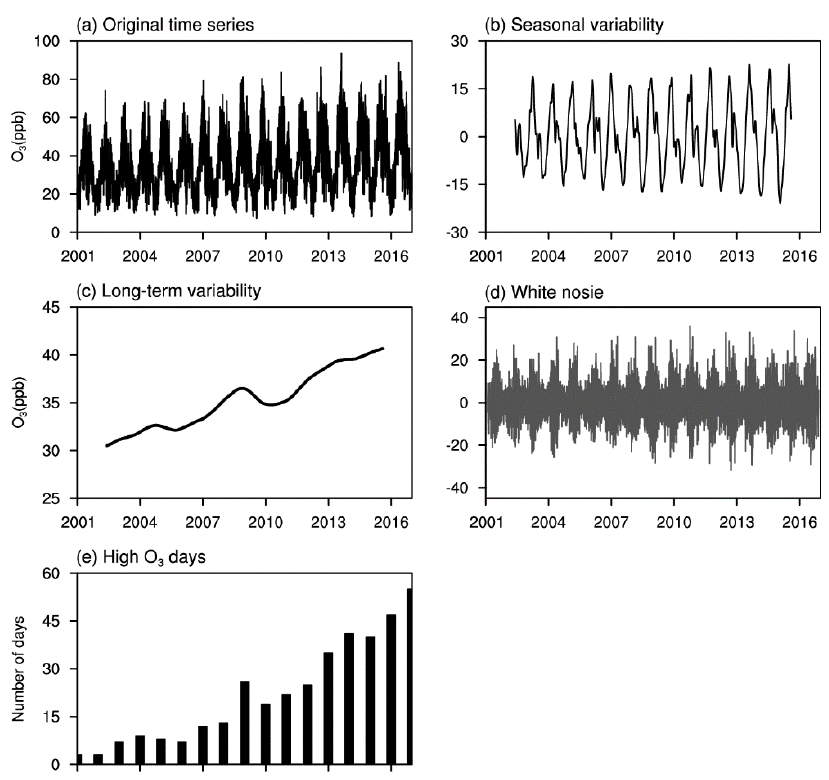
Figure 2. Kolmogorov–Zurbenco (KZ) filter analysis results: ( a ) original time series, ( b ) seasonal variability, ( c ) long-term variability and ( d ) white noise, ( e ) and number of days with high O 3 concentration.